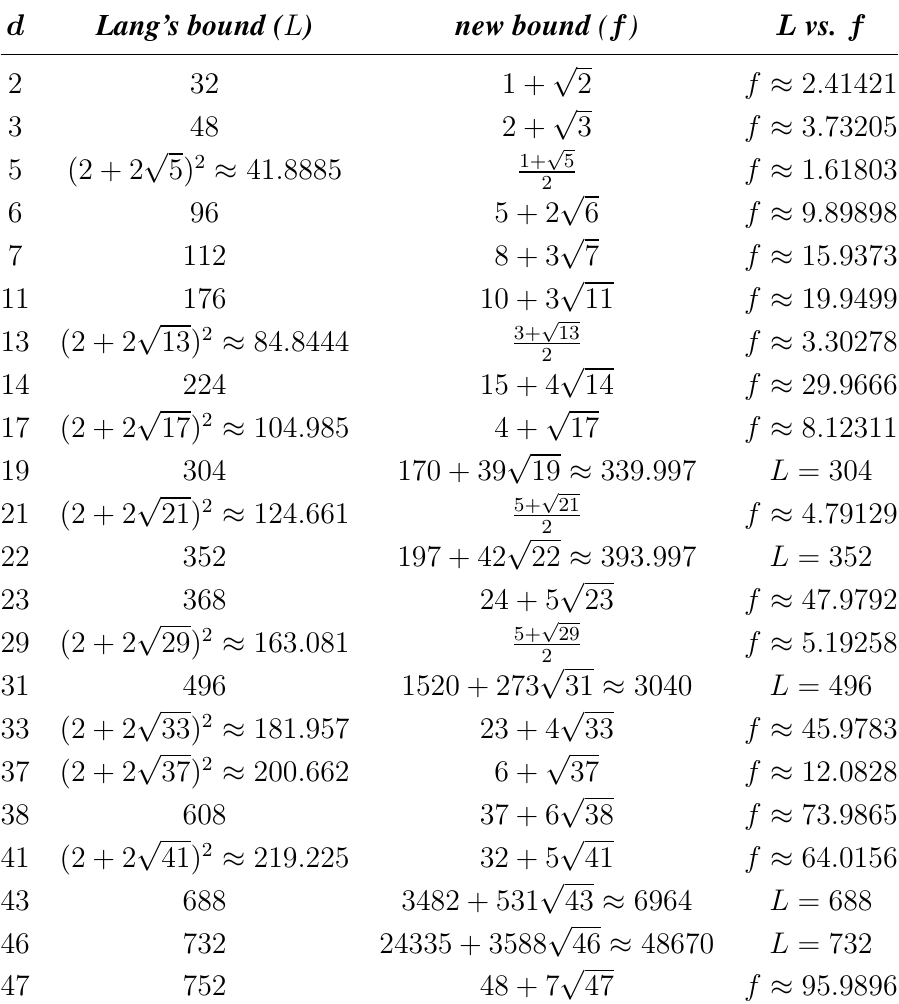
Table 1. Lang’s bound compared with the fundamental